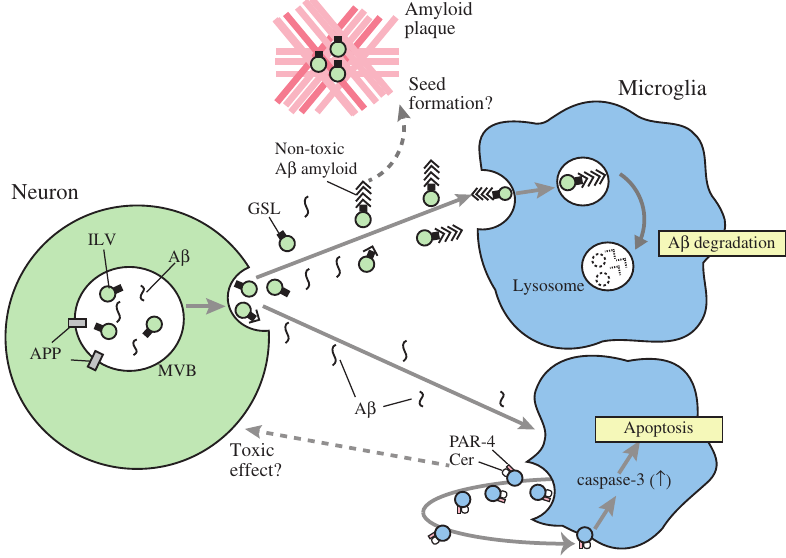
Figure 2: Roles of neuronal and microglial exosomes related to A b in Alzheimer’s disease. Neuronal exosomes are associated with intracellular or extracellular A b through GSLs abundant on the exosomal surface. Exosomes promote the assembly of nontoxic A b . A b -exosome complex is subsequently taken up into microglia to degrade A b . Neuronal exosomes likely promote A b clearance. In the absence of microglial phagocytic activity, exosome-associated A b might act as a seed for A b amyloid plaque. In turn, exosomes that are released from A b -stimulated microglia are autonomously incorporated into microglia and induces caspase-3-dependent apoptosis. Enriched Cer and PAR-4 in the microglial exosomes are responsible for the toxic